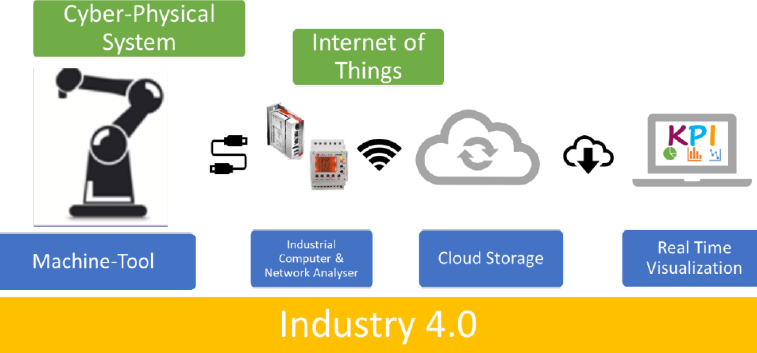
Figure 1. Integration for real-time acquisition.